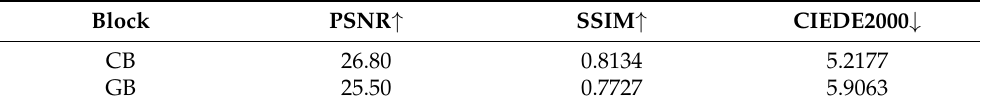
Table 5. Ablution analysis of the structure of GRB. The bold and underlined text indicates the best and second-best performance, respectively. The ↑ symbol indicates that larger values are better, while ↓ indicates that smaller values are